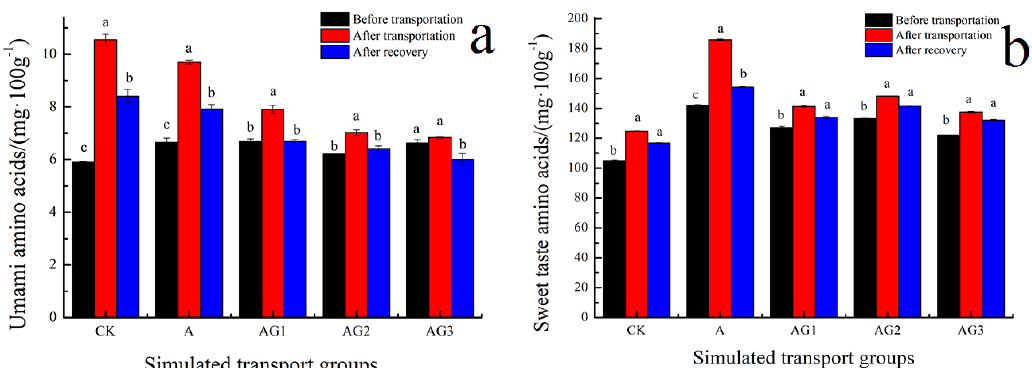
Figure 8. E ff ect of ascorbic acid and β -1,3-glucan addition on umami ( a ) and sweet ( b ) taste amino acids Figure 8. Effect of ascorbic acid and β-1,3-glucan addition on umami ( a ) and sweet ( b ) taste of tiger grouper during simulated transport. Among di ff erent treatments transport groups, di ff erent amino acids of tiger grouper during simulated transport. Among different treatments small letters indicate the results of Duncan’s test at di ff erent transport time. The same letters mean no transport groups, different small letters indicate the results of Duncan’s test at different significant di ff erence ( p > 0.05), while di ff erent letters mean significant di ff erence ( p < 0.05). Di ff erent transport time. The same letters mean no significant difference ( p > 0.05), while different letters without * = p -value < 0.05, di ff erent letters with ** = p -value < letters mean significant difference ( p < 0.05). Different letters without * = p- value < 0.05, different letters with ** = p- value < 0.01.